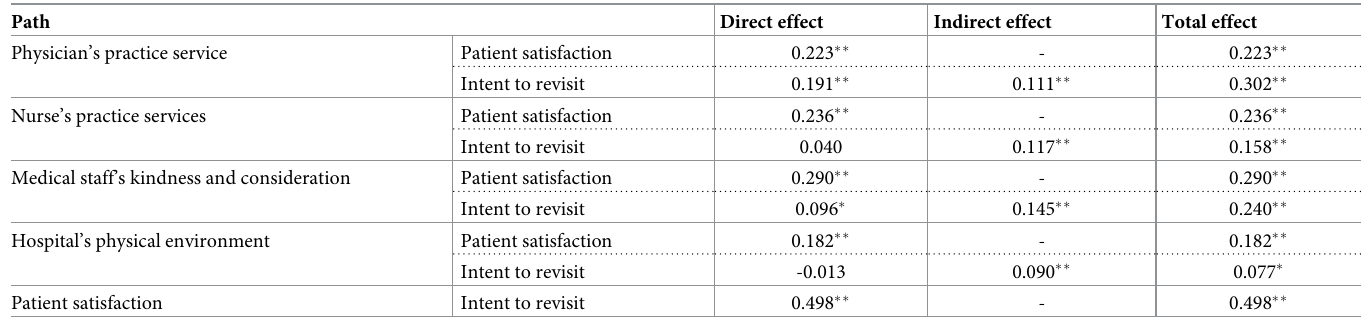
Table 5. Effect analysis